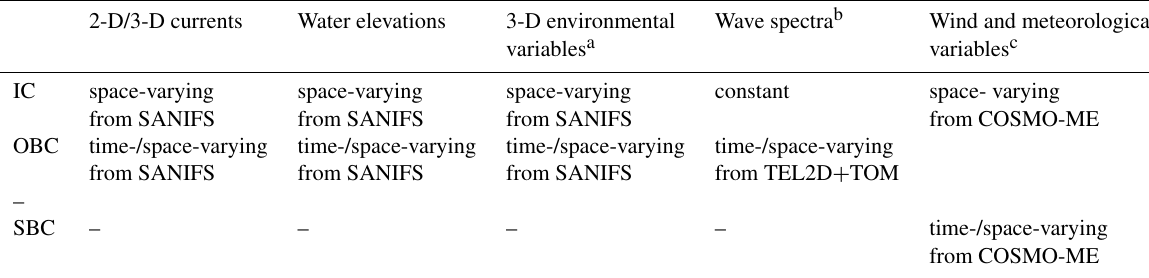
Table 2. Forcings for the different variables modeled in the proposed multiple-nesting approach.